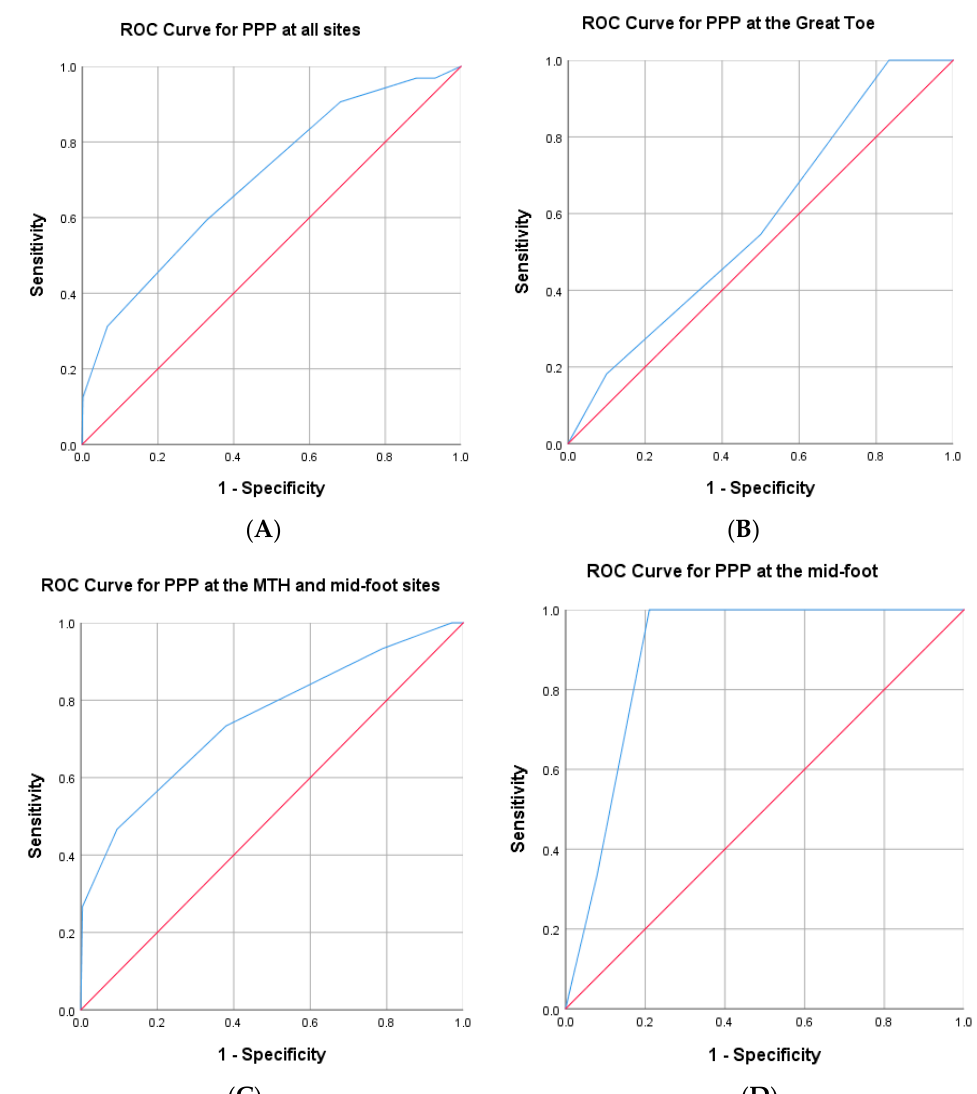
Figure 3. Receiver operating characteristic (ROC) curves for peak plantar pressure at ( A ) all plantar sites ( n = 504 sites); ( B ) great toe only ( n = 42 sites); ( C ) combined metatarsal and mid-foot sites ( n = 252 sites); ( D ) mid-foot only ( n = 42 sites). The ROC curves demonstrate the sensitivity and specificity for identifying plantar areas with a history of DFU at a threshold of 4.1 kg/cm 2 . A curve closer to the top left-hand corner indicates a more sensitive and specific test. The diagonal (45 ◦ ) line serves as a baseline for the area under the curve. ( A ) PPP threshold of 4.1 kg/cm 2 at any plantar site has 59% sensitivity and 67% specificity for predicting DFU history. Area under the curve = 0.70 (95% CI: 0.60–0.80; p < 0.0001), fair/good diagnostic ability. ( B ) Area under the curve = 0.58 (95% CI: 0.39–0.77, p = 0.44). There was no diagnostic ability of PPP at the great toe for predicting DFU history. ( C ) PPP threshold of 4.1 kg/cm 2 at the metatarsal heads and mid-foot had 73% sensitivity and 62% specificity for predicting DFU history. Area under the curve = 0.75 (95% CI: 0.61–0.90; p < 0.001), very good diagnostic ability. ( D ) PPP threshold of 4.1 kg/cm 2 at the mid-foot alone had 100% sensitivity and 79% specificity for predicting DFU history. Area under the curve = 0.89 (95% CI: 0.78–1.00; p = 0.026), excellent diagnostic